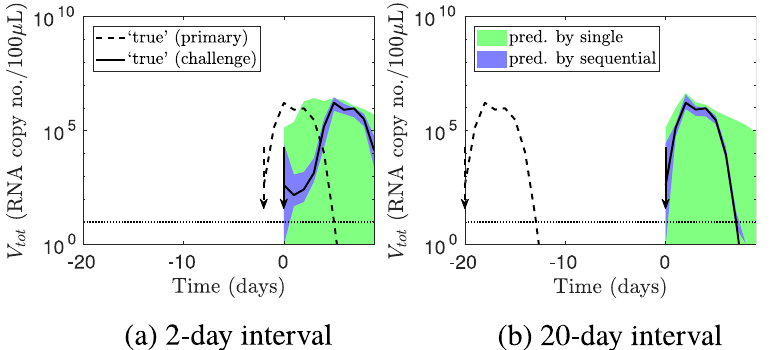
Fig 4. Predicting the outcomes of further sequential infection experiments. Sequential infection data, but not single infection data, enabled prediction of further sequential infection experiment outcomes. The lines show the simulated ‘true’ viral loads for inter-exposure intervals of (a) 2 and (b) 20 days. The shaded areas show the 95% prediction intervals for the challenge viral